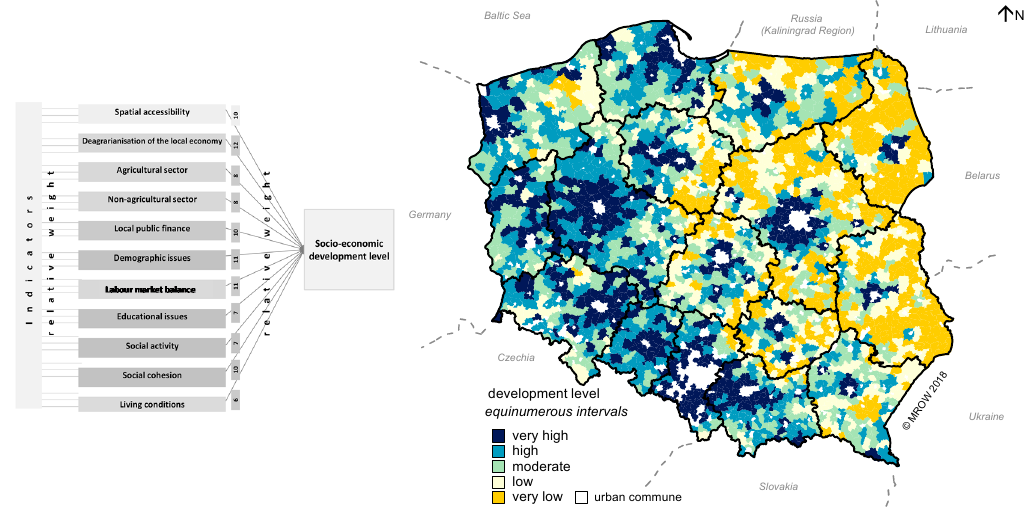
Figure 1. Synthetic measure of socioeconomic development level in rural areas in Poland 1 . Source: [20] (p. 16; 219).